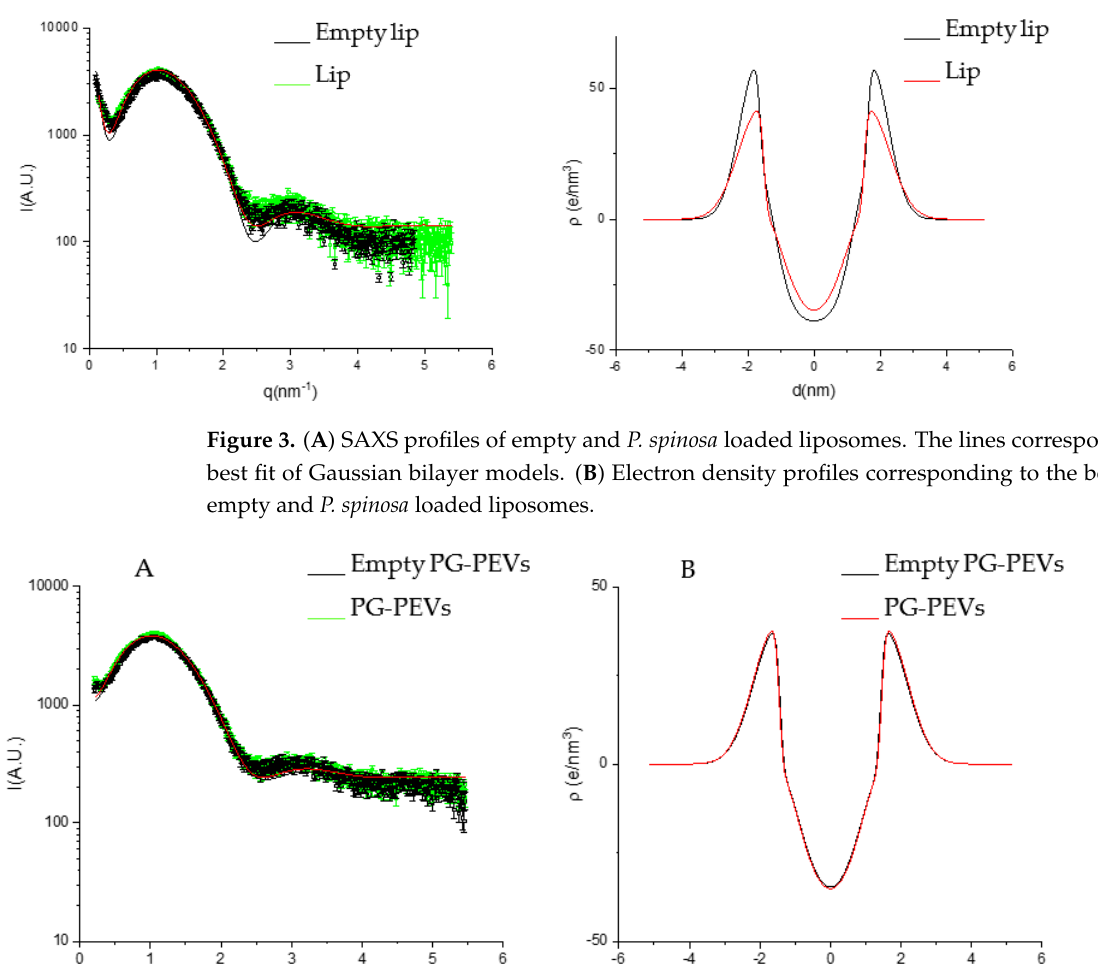
Figure 4. ( A ) SAXS profiles of empty and P. spinosa loaded PG-PEVs. The lines correspond to the best fit of Gaussian bilayer models. ( B ) Electron density profiles corresponding to the best fits of empty and P. spinosa loaded PG-PEVs. Table 7. Fitting parameters and derived parameters (±estimated error from the fit) for SAXS curves of empty and P. spinosa nanoformulations.